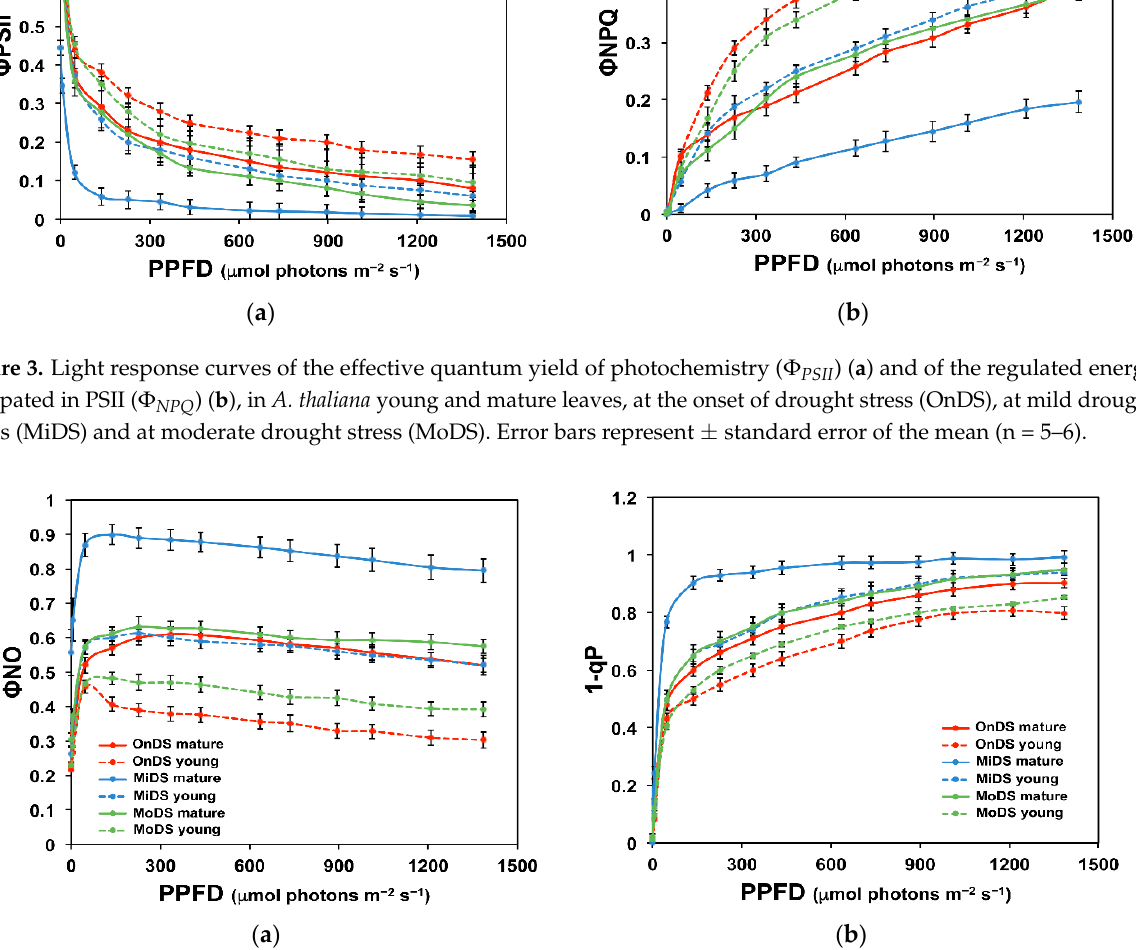
) ( a ) and of excitation pressure (1 − q p ) ( b ), NO